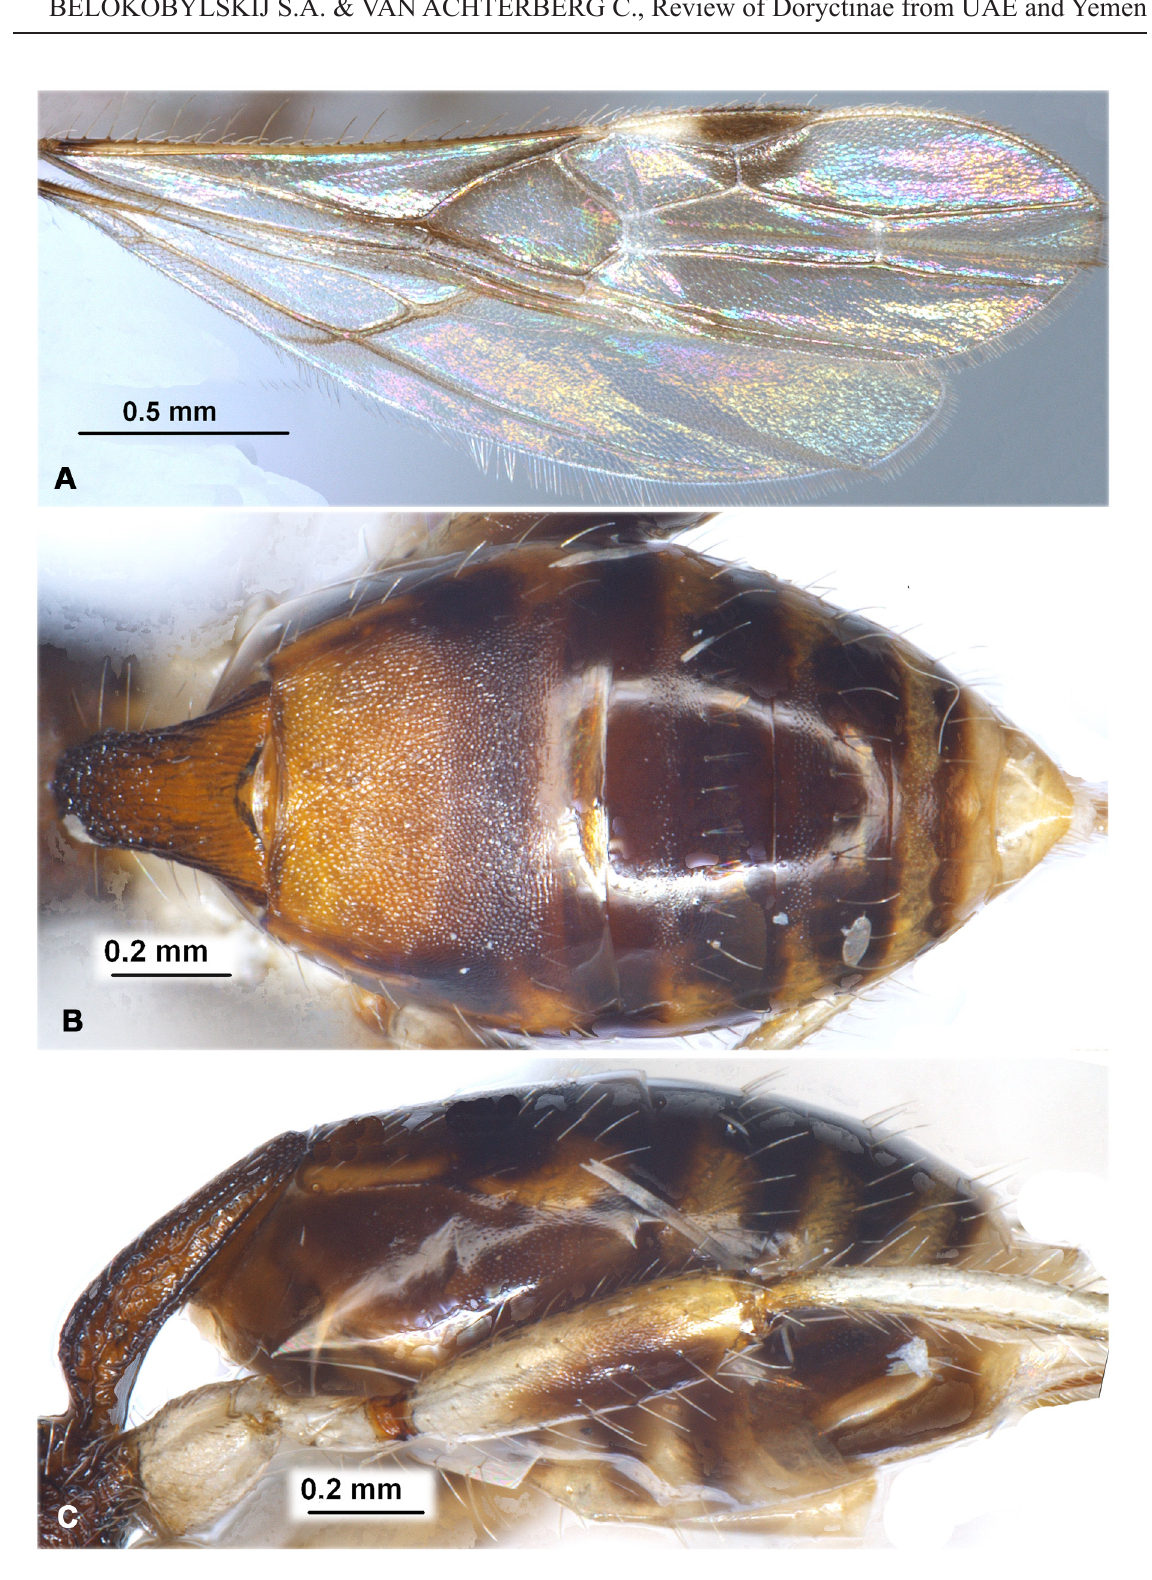
Fig. 25. Spathius subafricanus Belokobylskij sp. nov., holotype, ♀ (RMNH). A . Wings. B . Metasoma, dorsal view. C . Metasoma, lateral